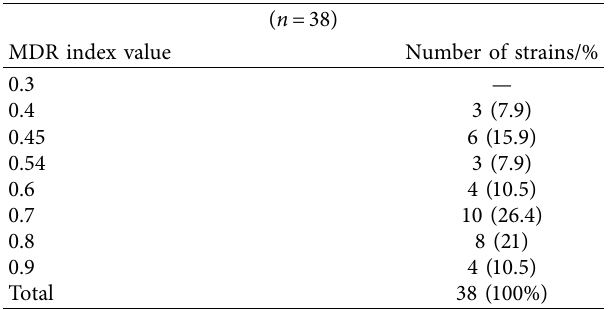
Table 7: Multidrug resistance index of pathogenic Escherichia coli